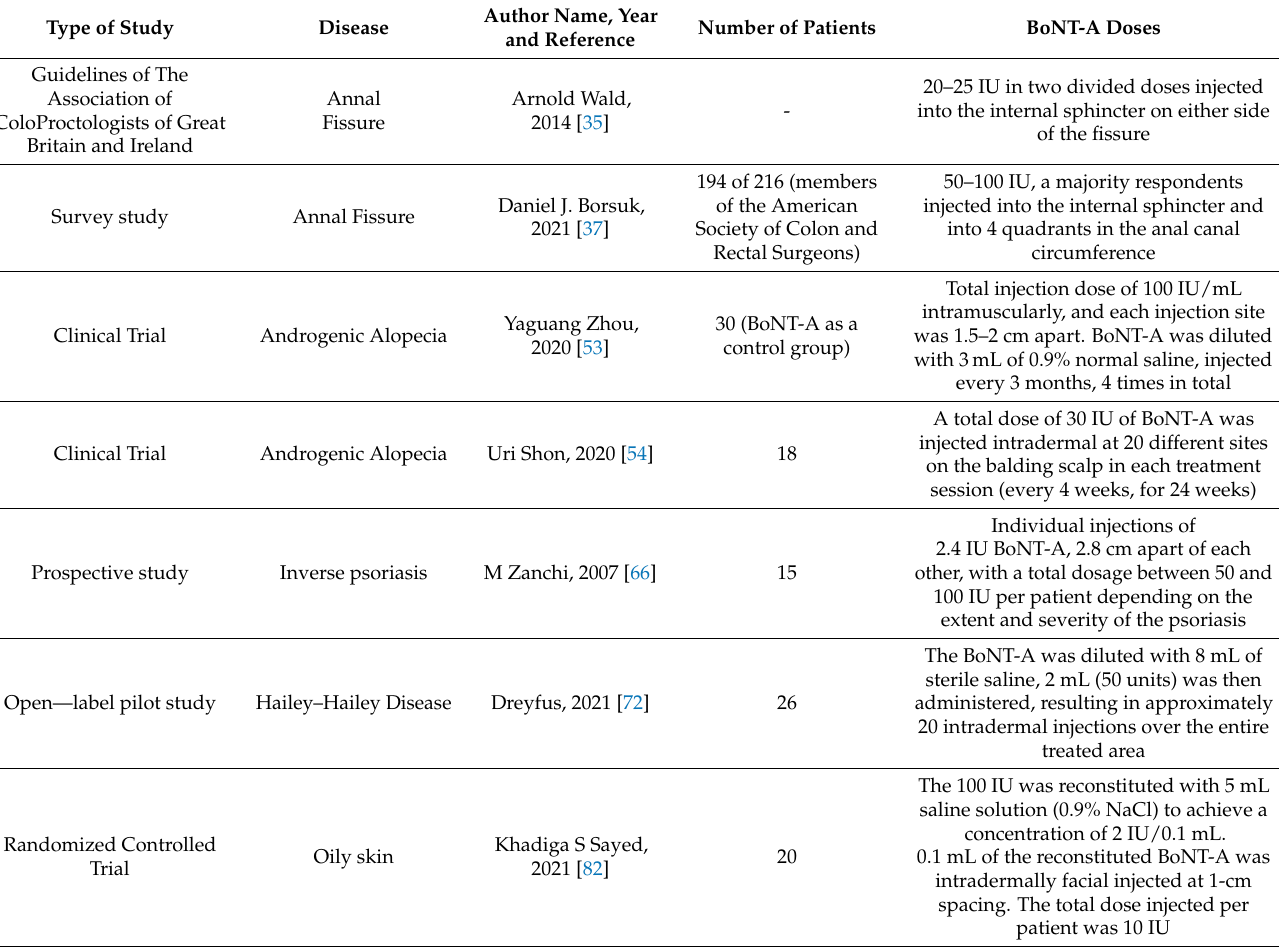
Table 3. Proposed BoNT-A dosing schemes in selected diseases according to the guidelines or original research (clinical trials, prospective studies), which demonstrated the efficacy of